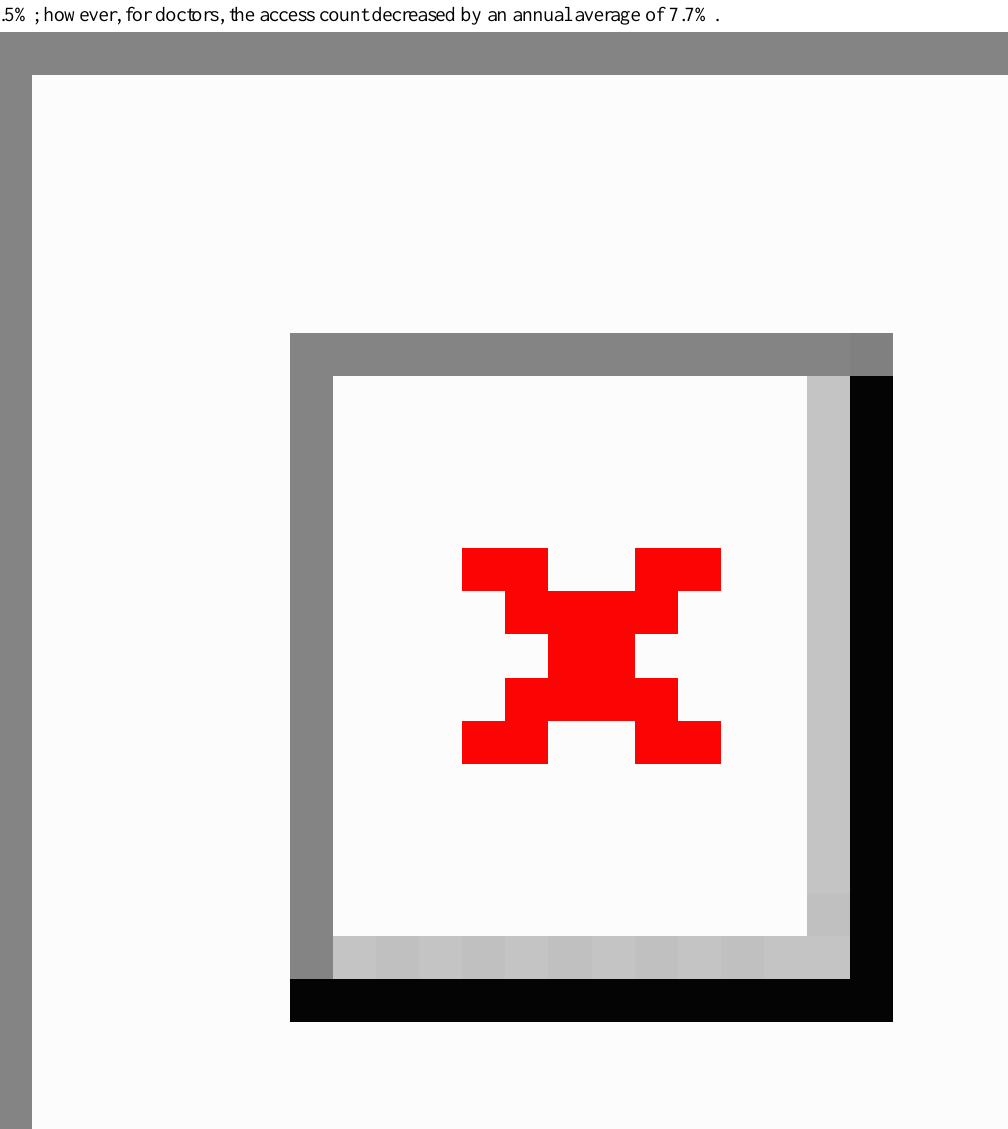
Figure 3. Annual trends in hourly usage of the mobile Asan Medical Information System. The access count for nurses increased by an annual average